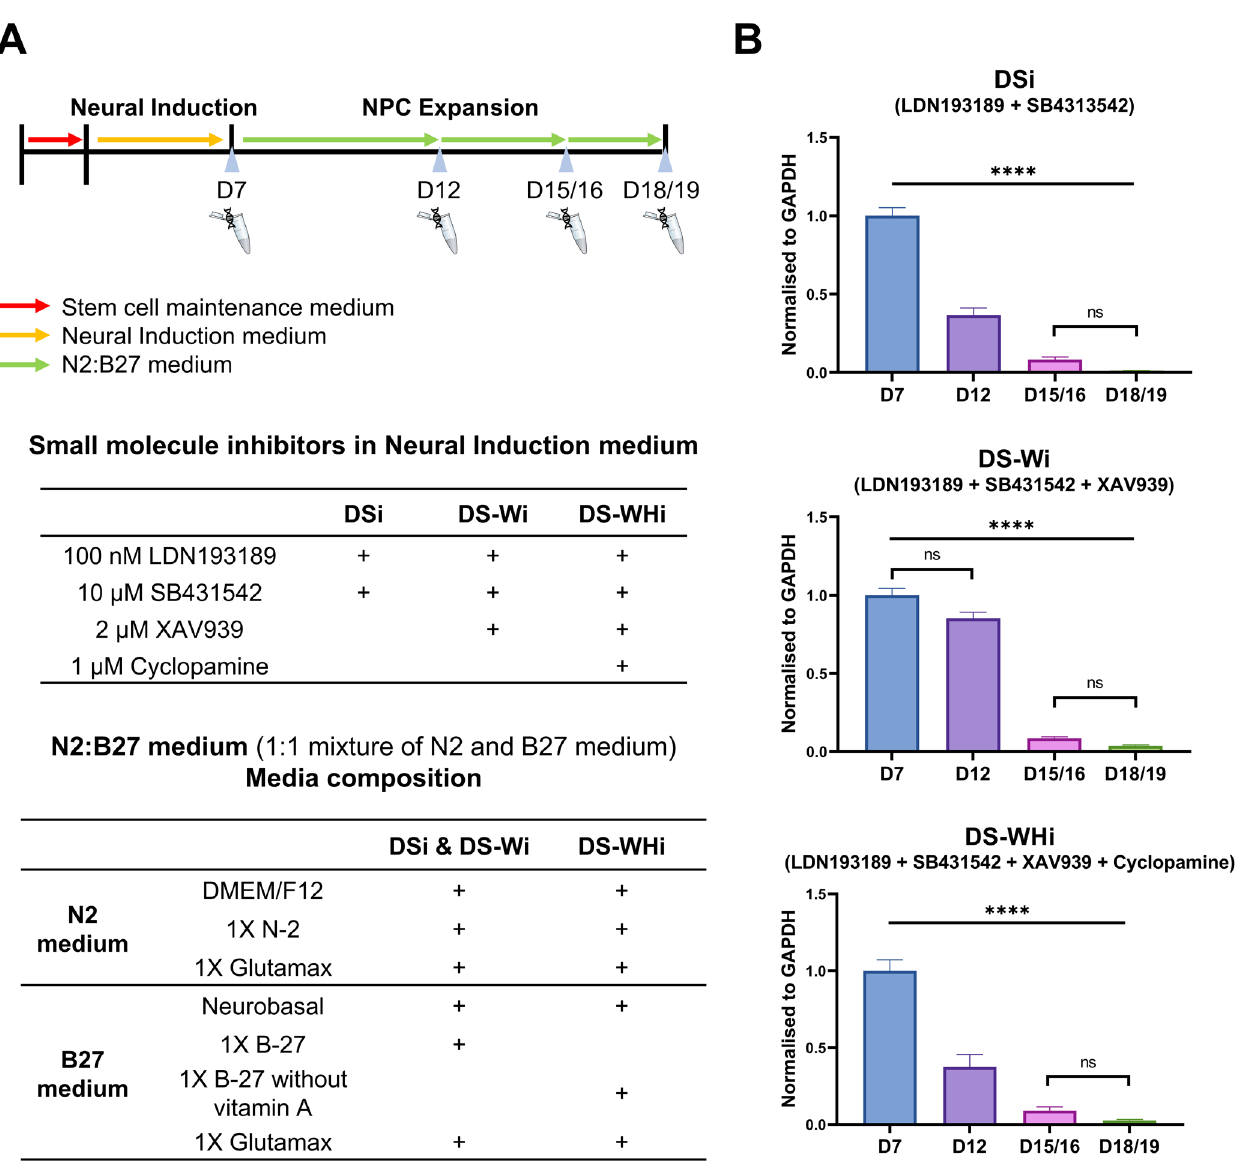
Figure 2. APOE gene expression changes according to the differentiation state of cells during in vitro directed differentiation. A ) Schematic diagram of directed differentiation. CTR_M3_36S iPSCs were maintained in stem cell maintenance medium after replating (D-2/-1). On D0 neural induction began by changing the stem cell maintenance medium to neural induction medium. N2:B27 was used from D8 onwards. Medium was changed every 24 hrs throughout the entire differentiation period. Neural passaging 1, 2, and 3 were carried out on D7, D12, and D15/16, respectively. Total RNA extraction was made on cells that were not used for neural passaging on D7, D12, D15/16, and D18/19. Neural induction medium composition for each differentiation lineage and N2:B27 medium composition are also shown. B ) APOE gene expression is reduced along neural induction regardless of lineage. Real-time qPCR was performed on CTR_M3_36S iPSCs undergoing directed differentiation at D7, D12, D15/16, and D18/19. APOE expression was normalised to that of GAPDH . D7 samples were used as reference samples for each lineage. One-way ANOVA with Bonferroni correction. n = 3. Mean (bars) with S.E.M. (error bars) shown. **** ANOVA p-value < 0.0001. ns: non-significant after Bonferroni correction. DSi: dual SMAD inhibition. DS-Wi: DSi plus Wnt/ β -catenin inhibition. DS-WHi: DS-Wi plus sonic hedgehog